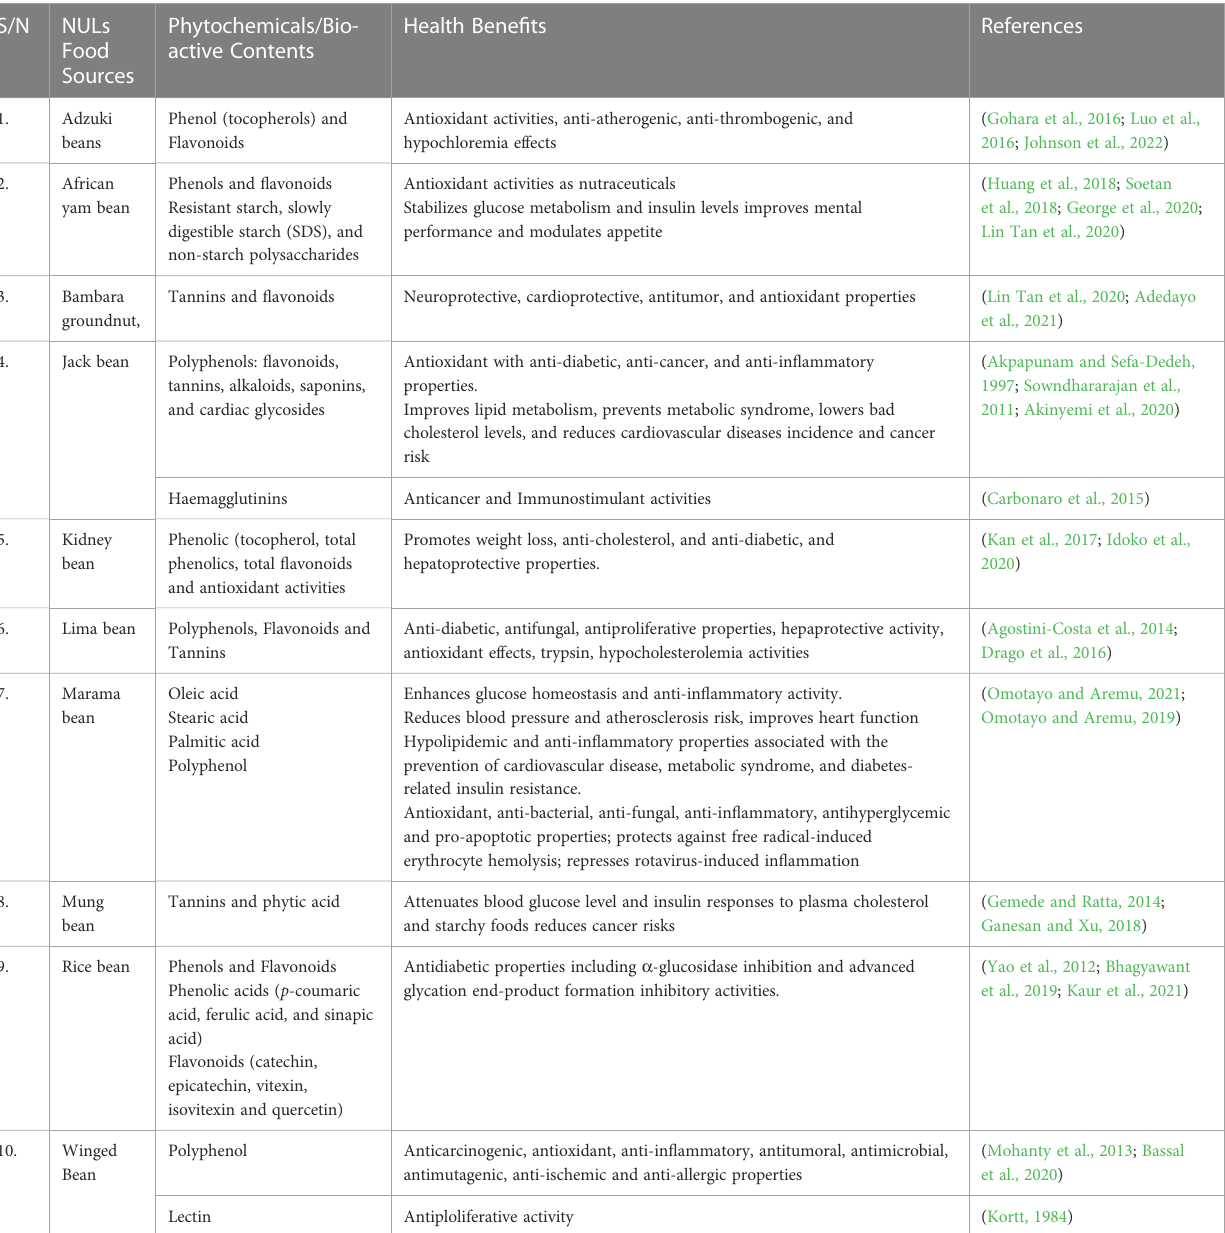
TABLE 4 Bioactive components of the selected neglected and underutilized